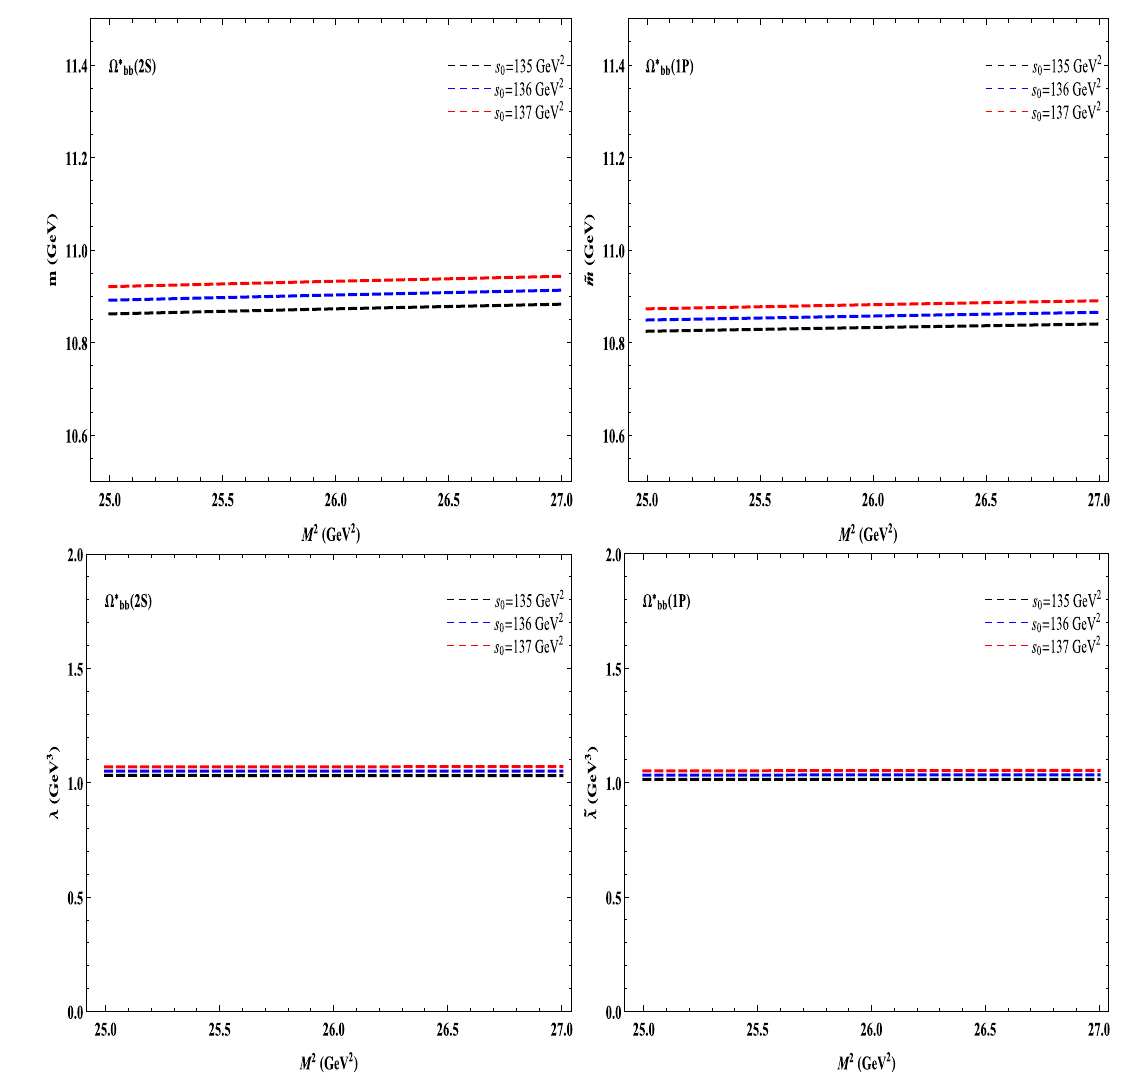
Fig. 7 The dependency of the excited states 2 S , 1 P masses, and pole residues of the doubly-heavy of spin-(3/2) (cid:3) ∗ M 2 at different values of the continuum threshold s 0